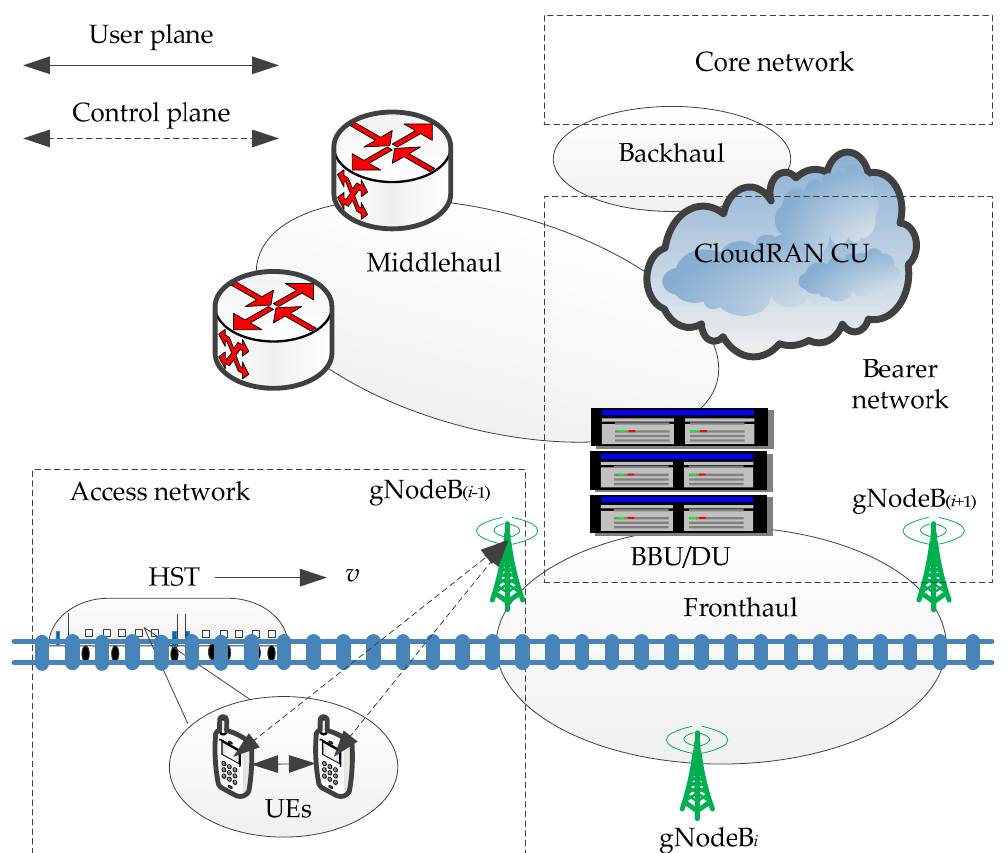
Figure 2. Architecture of networks in 5G for railway (5G-R) for high-speed railways (HSRs).